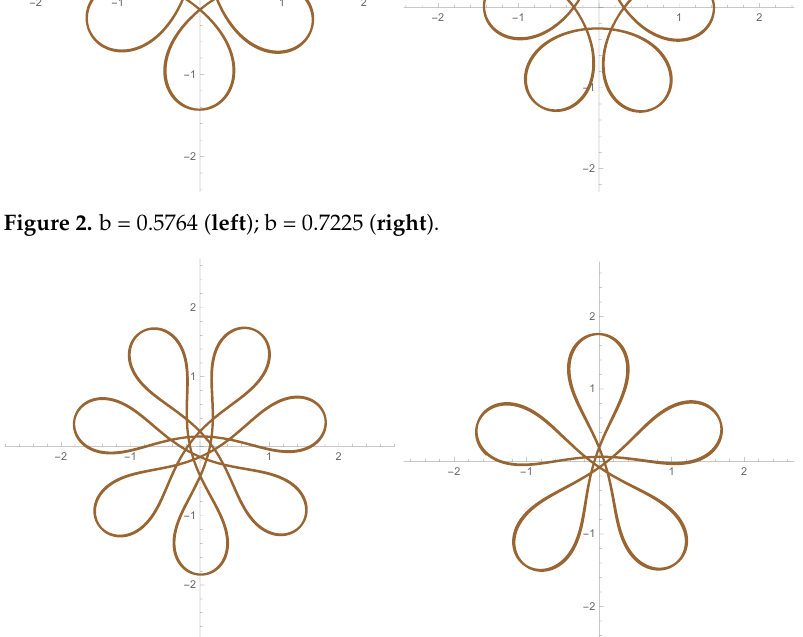
Figure 2. b = 0.5764 ( left ); b = 0.7225 ( right ).